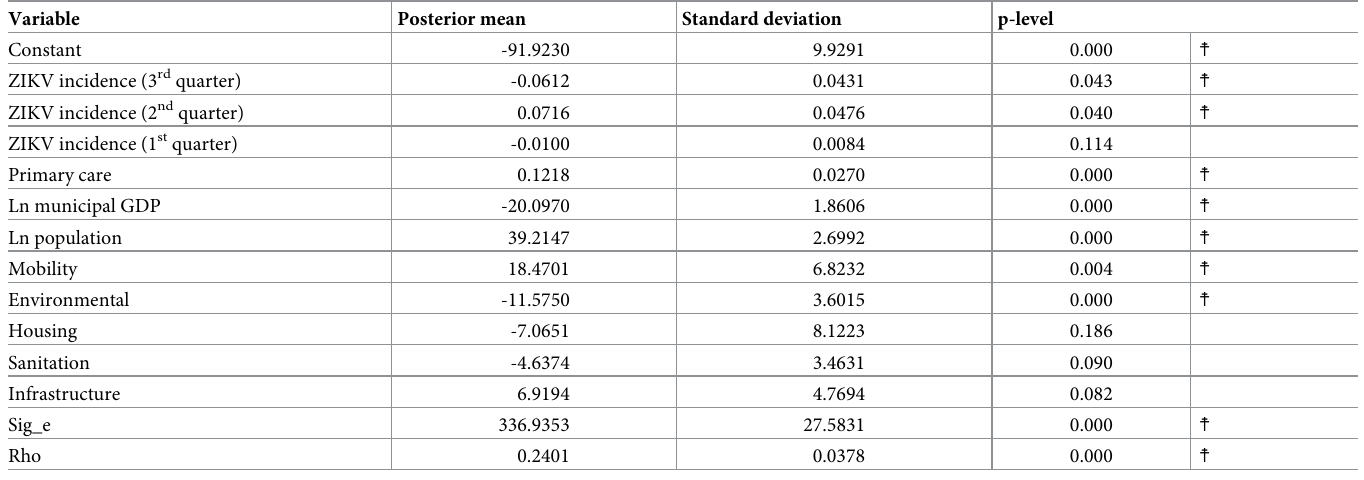
Table 3. Results of SAR Tobit—Dependent variable: Microcephaly incidence (4 th quarter),